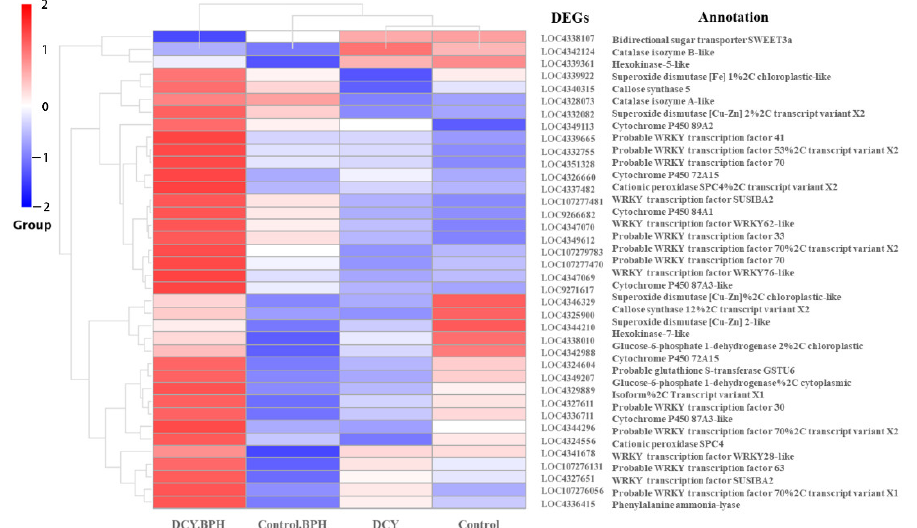
Figure 7. Fold change patterns of representative pathway genes. Each column shows a comparison and each row represents a gene. Colors represent fold-change values. Red represents upregulation, and blue represents downregulation.